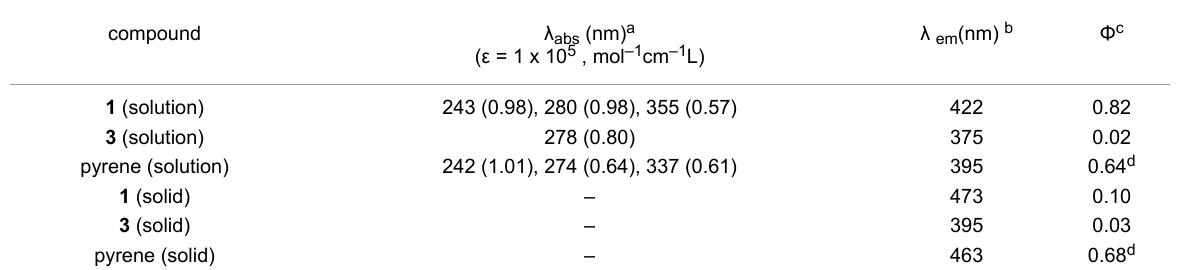
Table 1: Absorption, emission and quantum yield data for 1, 3 and